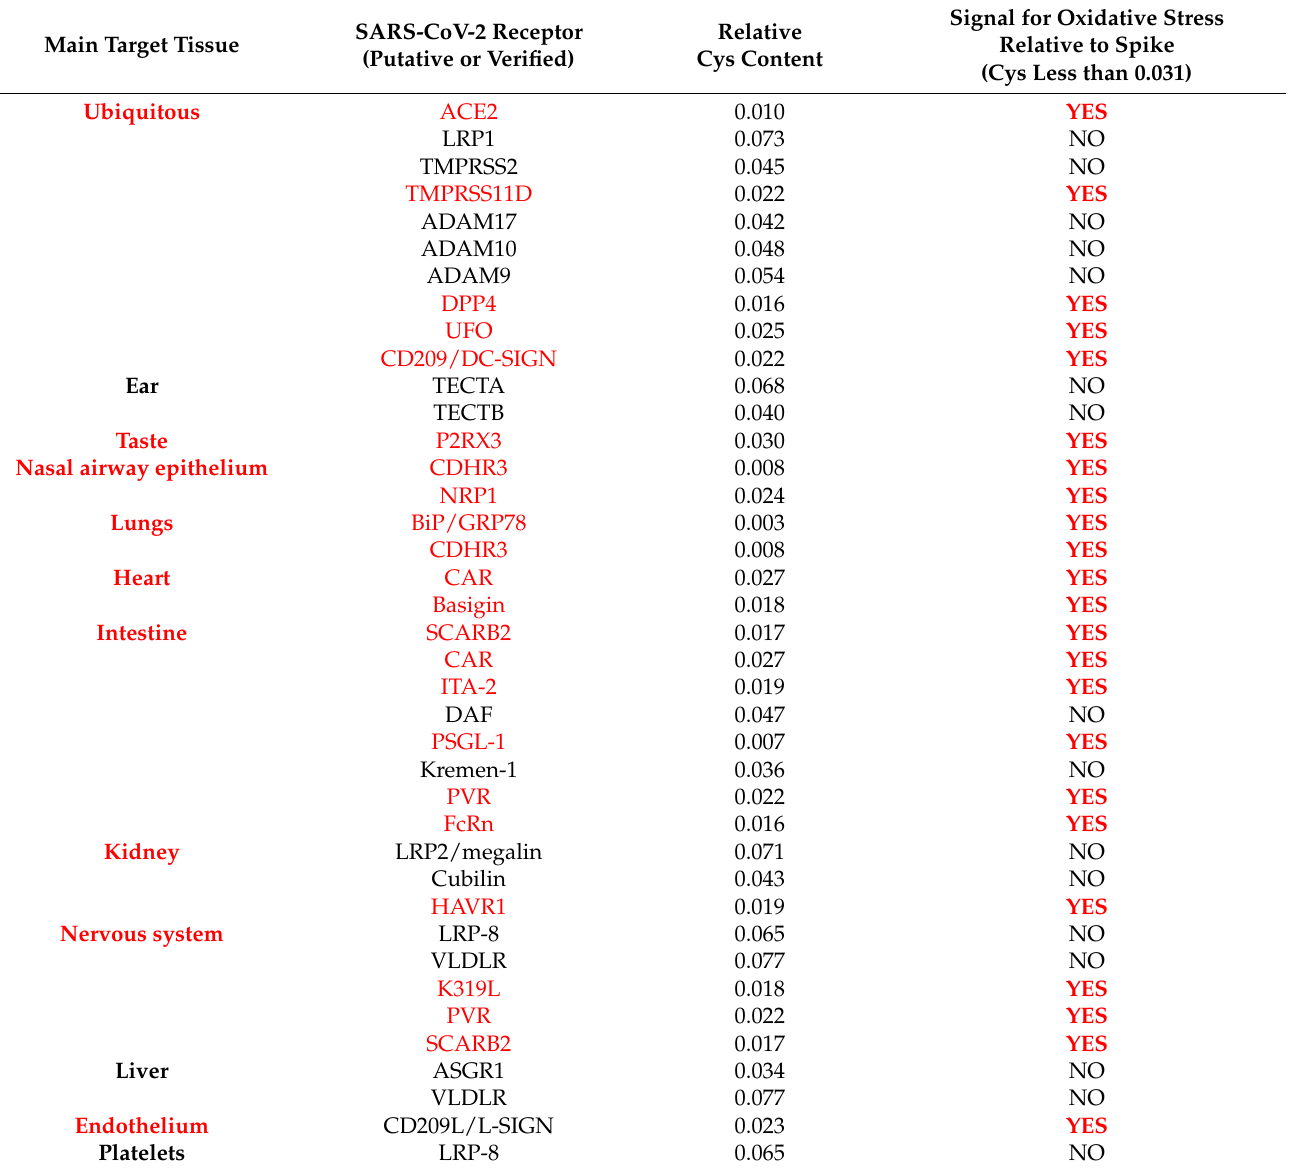
Table 3. Proteins of interest were analyzed for their relative Cys content. Tissues highlighted in red are proposed as most prone to oxidative stress because they are poor in